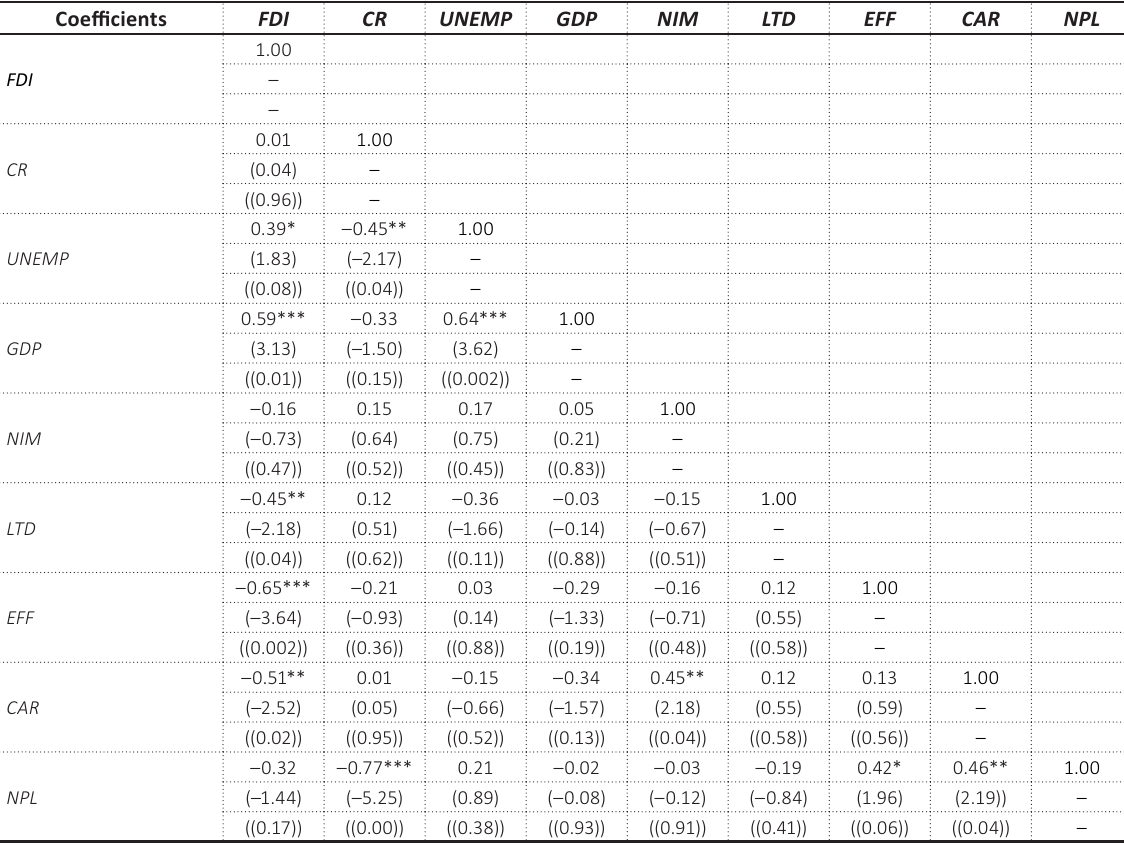
Table 3. Correlation table for NPL